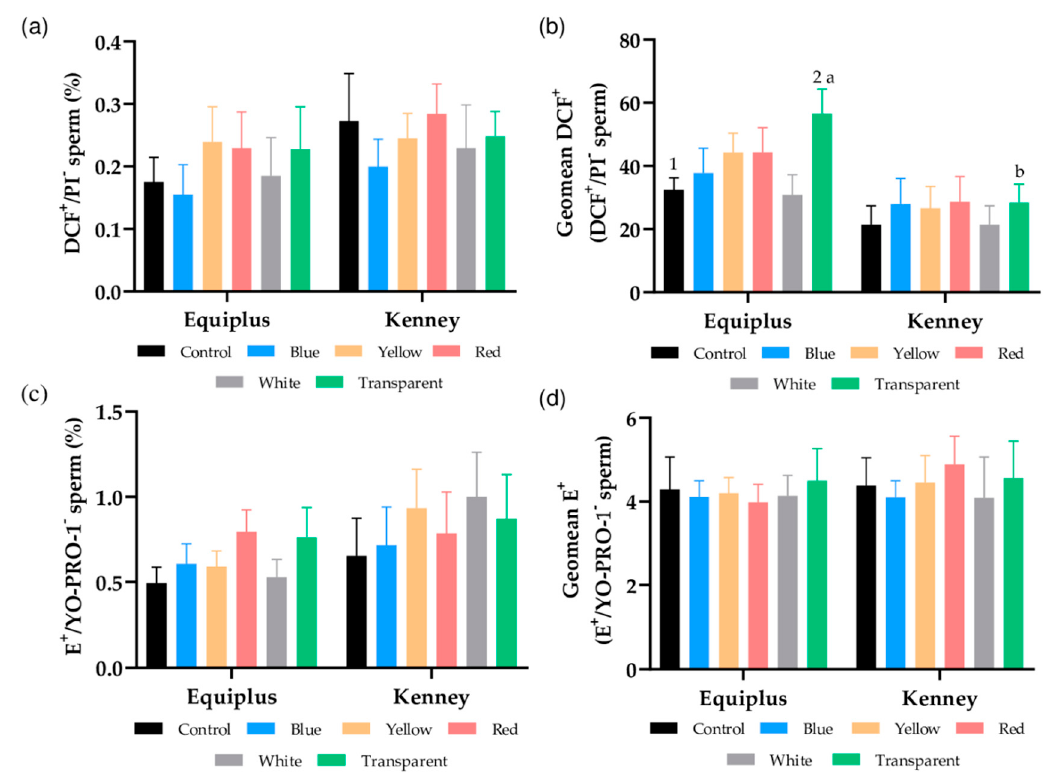
Figure 3. Effects of the color of the straw, extender, and light stimulation on intracellular ROS levels in control (nonirradiated) and irradiated samples packed into straws of different color and extended either with Equiplus or Kenney extender. Data are shown as ( a ) percentages of viable spermatozoa with high peroxide levels (DCF + /PI − ); ( b ) geometric mean of DCF + -intensity (GMFI, FL1 channel) in the population of viable spermatozoa with high peroxide levels (DCF + /PI − ); ( c ) percentages of viable spermatozoa with high superoxide levels (E + /YO-PRO-1 − ); ( d ) geometric mean of E + -intensity (GMFI, FL3 channel) in the population of viable spermatozoa with high superoxide levels (E + /YO-PRO-1 − ). Different numbers (1, 2) indicate significant differences ( p < 0.05) between nonirradiated and irradiated samples packed into straws of different color within the same diluent. Different letters (a, b) indicate significant differences ( p < 0.05) between the two extenders within nonirradiated or samples irradiated packed into straws of different color. The absence of numbers or letters indicates the lack of statistical difference between irradiated and nonirradiated samples within the same diluent or when comparing a given treatment between Kenny and Equiplus extenders. Data are shown as mean ± SEM of 13 separate experiments.